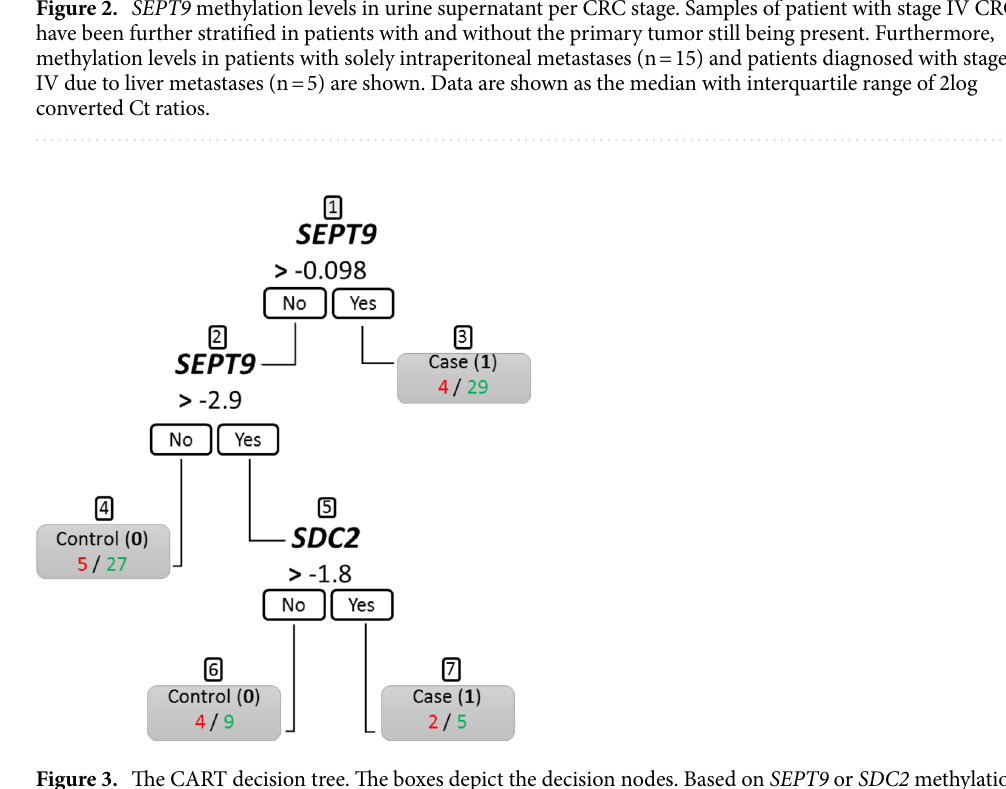
Figure 3. The CART decision tree. The boxes depict the decision nodes. Based on SEPT9 or SDC2 methylation values, samples are classified as a case (1) or control (0). The numbers below the node represent urine samples that are classified incorrectly (red) or correctly (green) according to the classification of 0 or 1. Node numbers are indicated above by 1 to